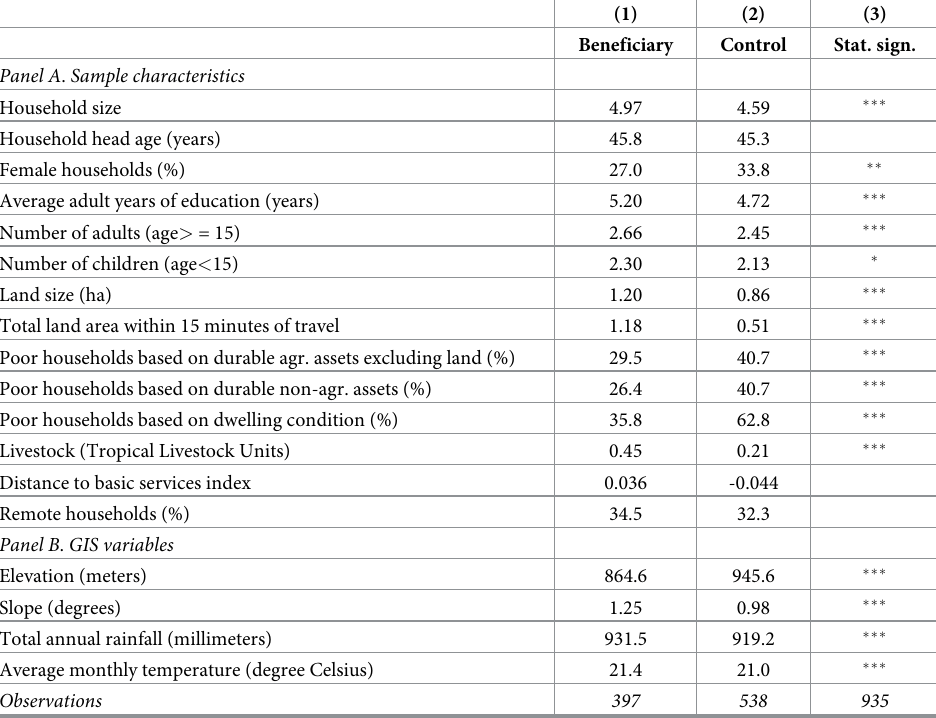
Table 1. Descriptive summary of socioeconomic variables by beneficiary